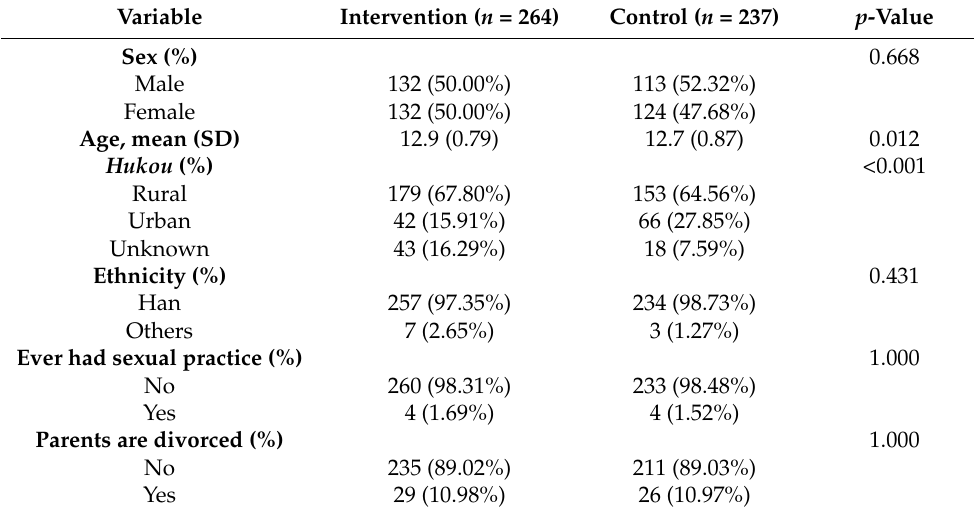
Table 1. Baseline characteristics of students by intervention